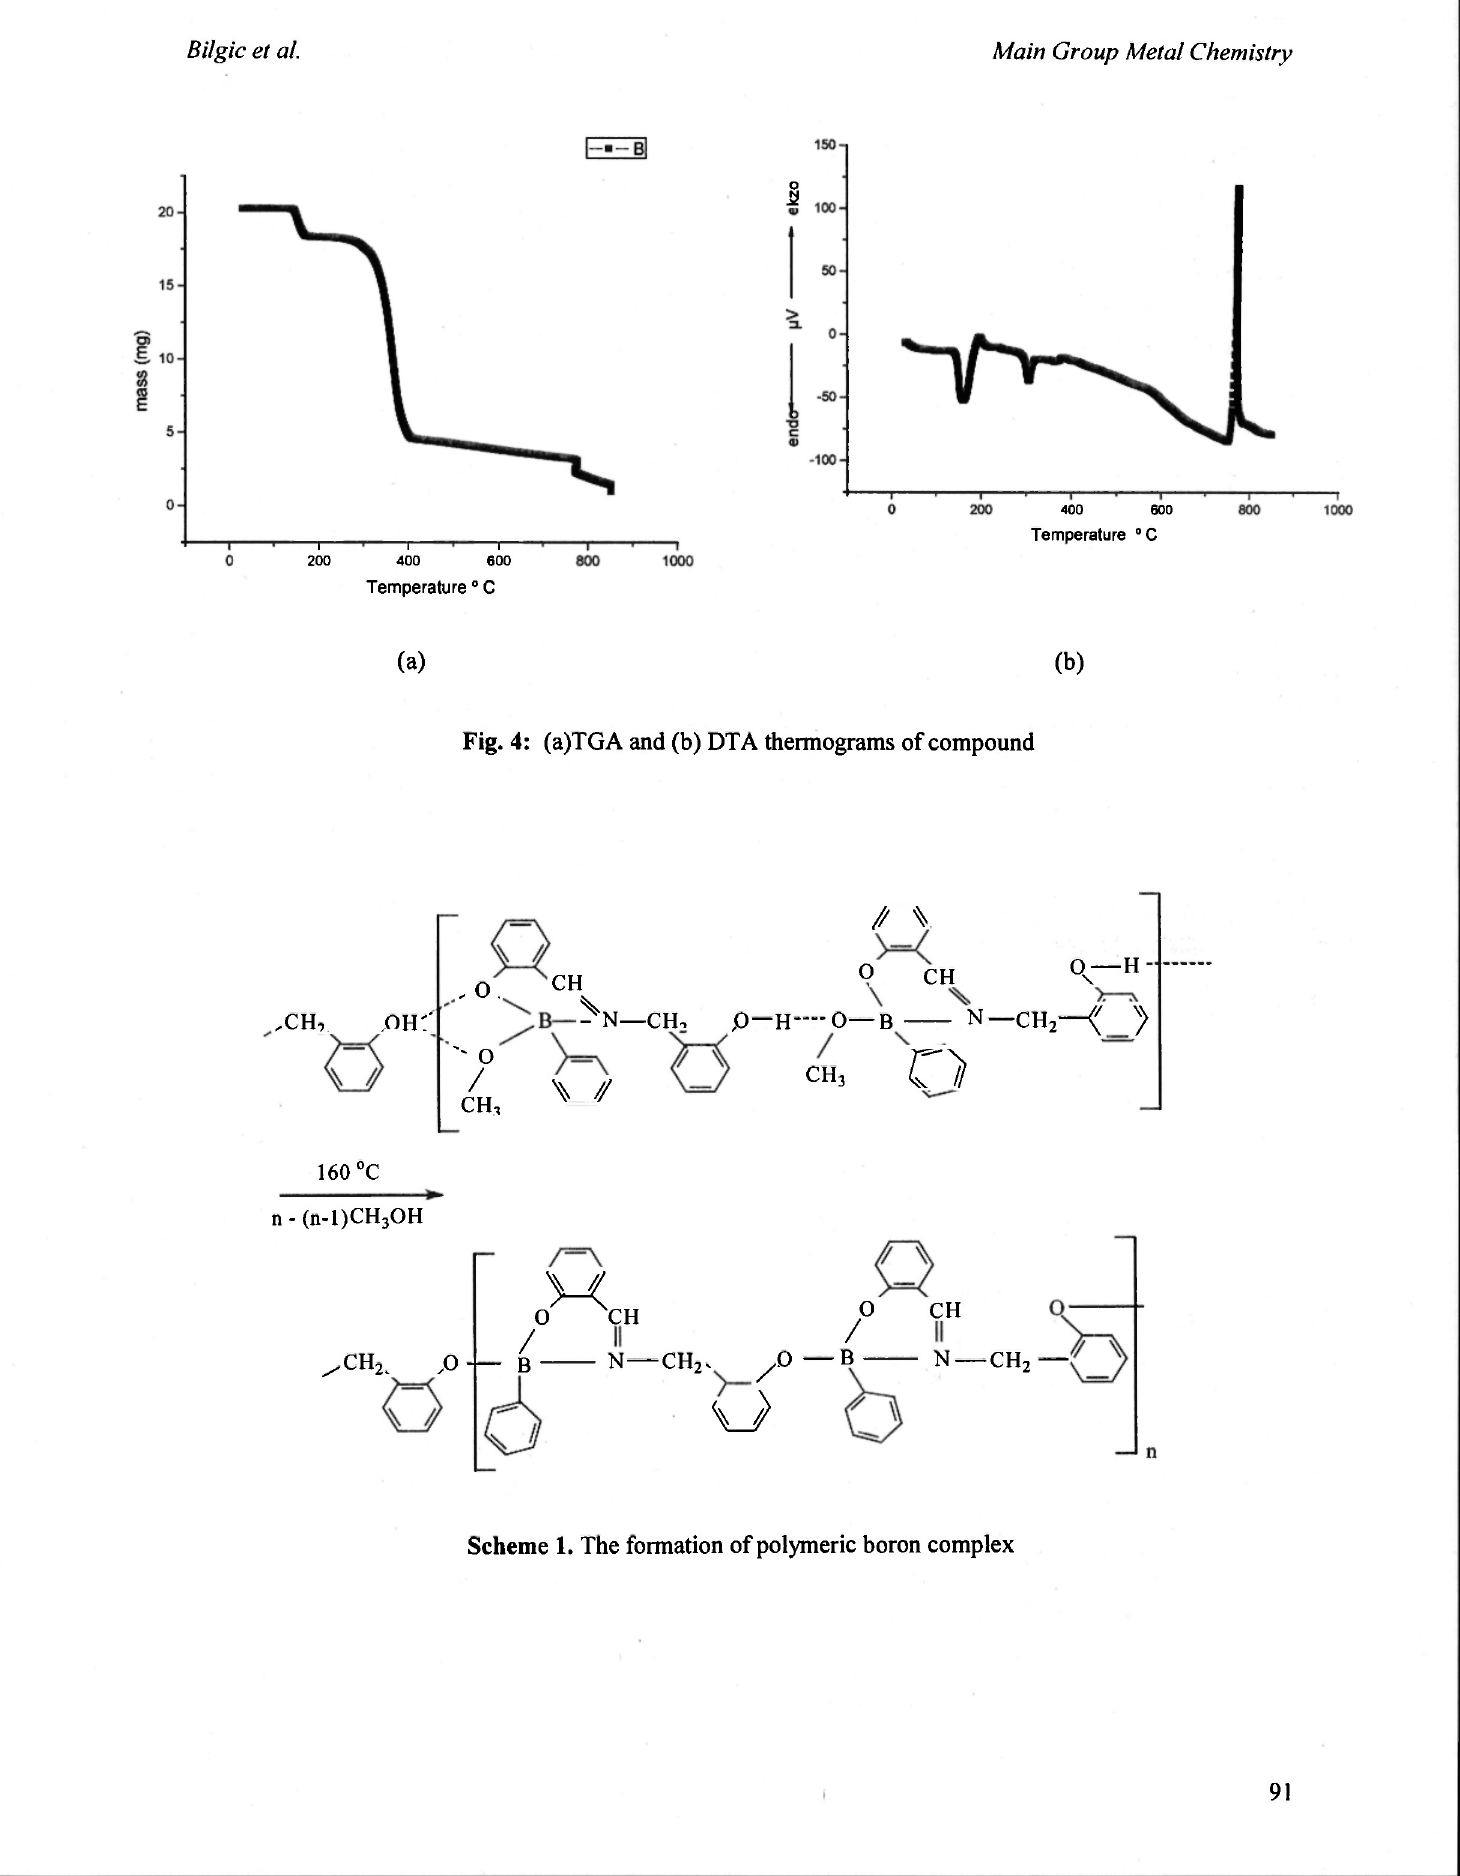
Scheme 1. The formation of polymeric boron